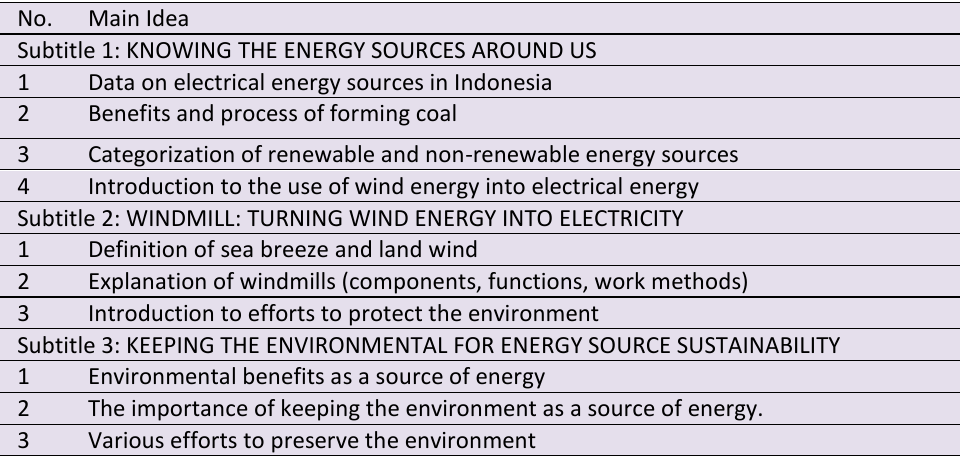
Table 7 . Pictorial Story